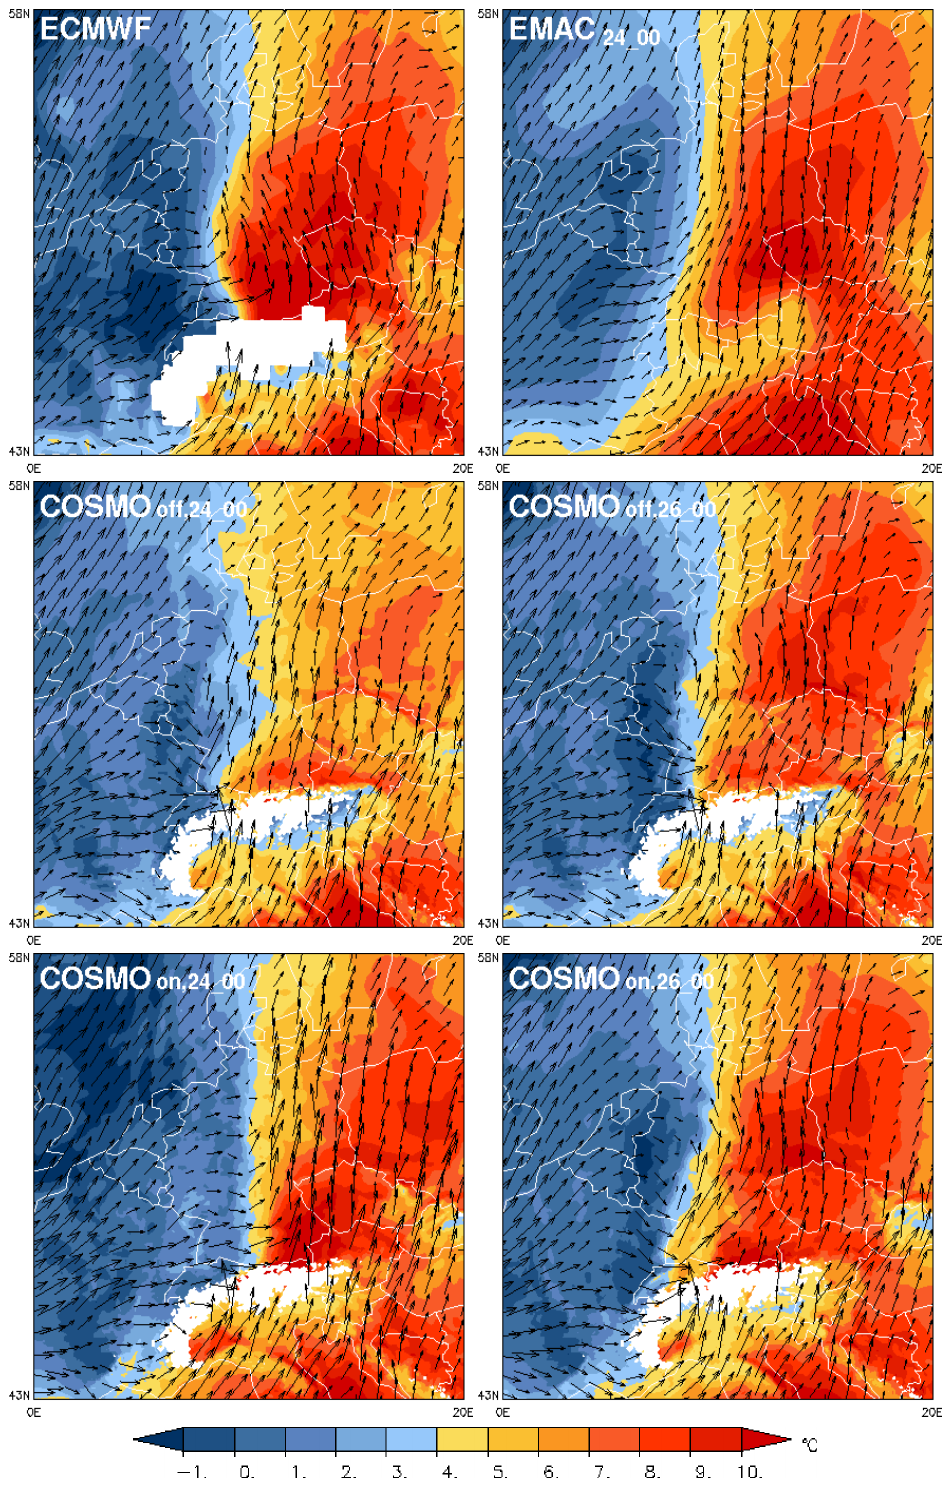
Fig. 5. Temperature (colours, in ◦ C) and horizontal wind vectors at 850hPa at 12:00UTC, 26 March 2010 for different model simulations and ECMWF analyses (top left panel).